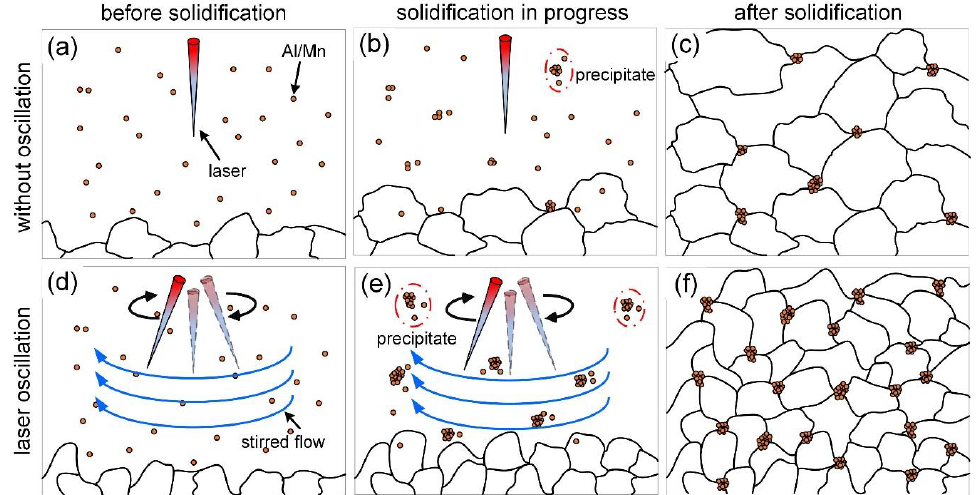
Figure 15. Schematic diagram of microstructure evolution induced using oscillating laser. ( a – c ) without oscillation; ( d – f ) laser oscillation. oscillation; ( d – f ) laser